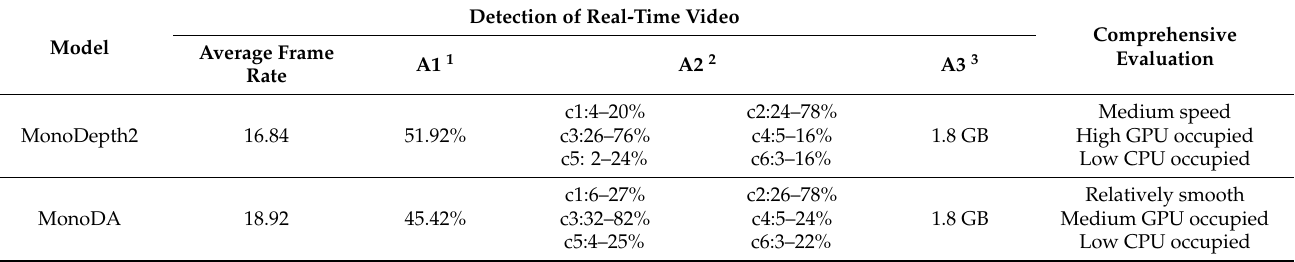
Table 5. Results of real-time depth estimation on TX2.